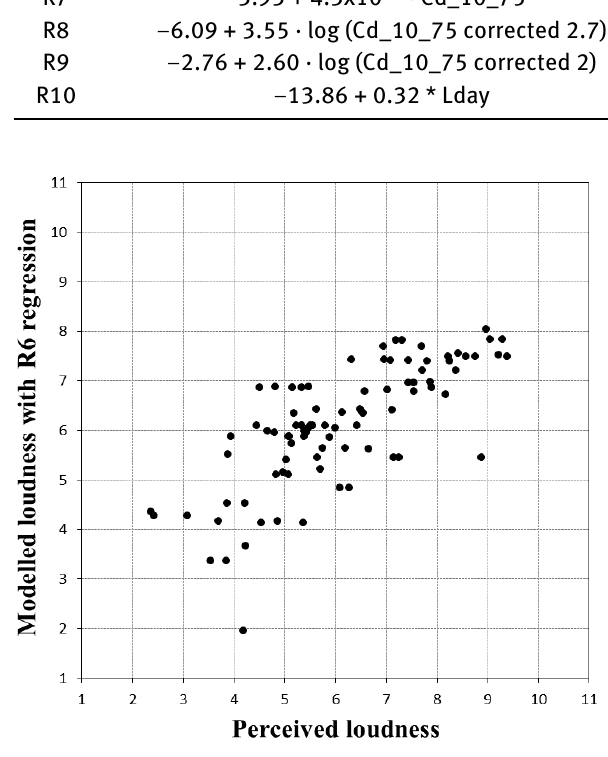
Figure 6: Relation between perceived and modelled loudness with the